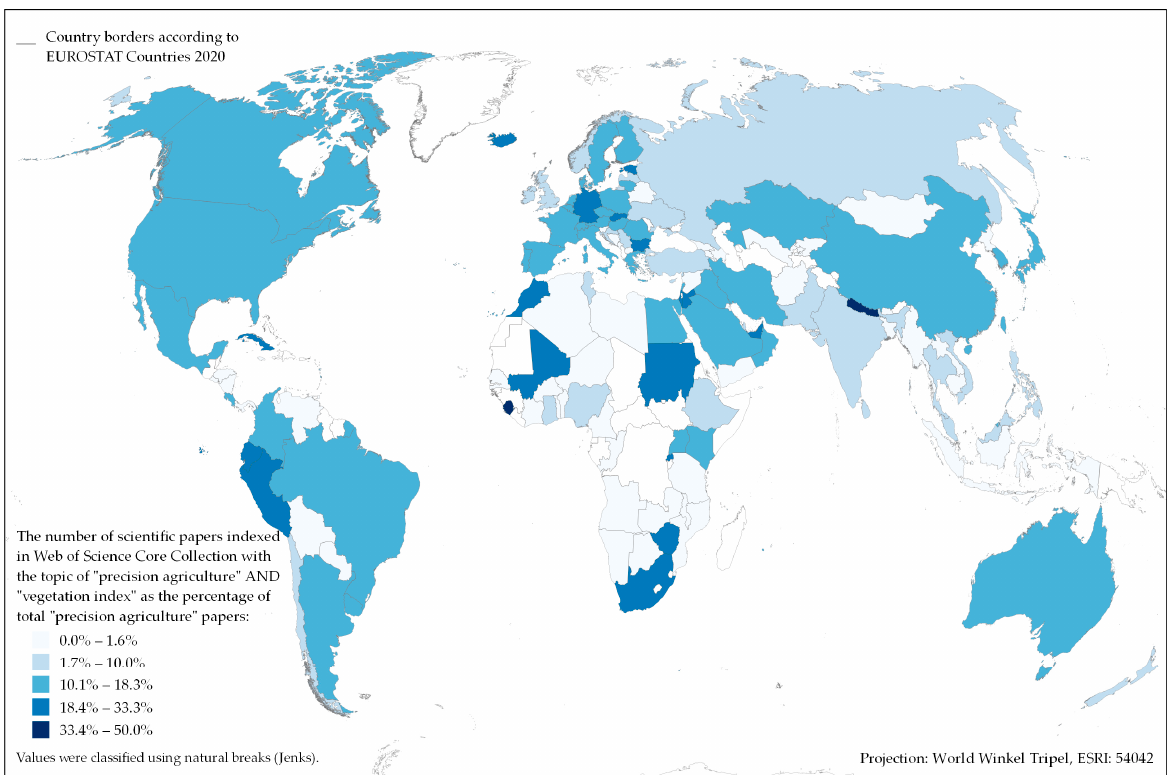
Figure 4. Global map of the percentage of scientific papers indexed in WoSCC since 2010 with the topic of “precision agriculture” AND “vegetation index” from the overall number of studies with the topic of “precision agriculture”.